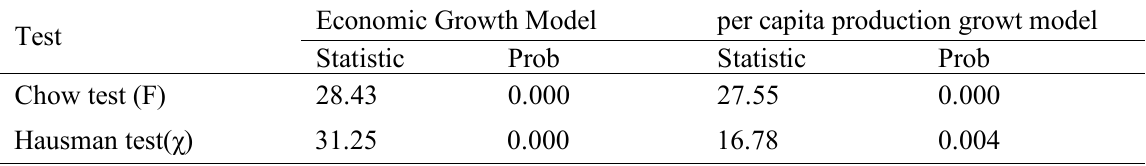
Table 2 . results of test Estimate panel patterns in Developed countries